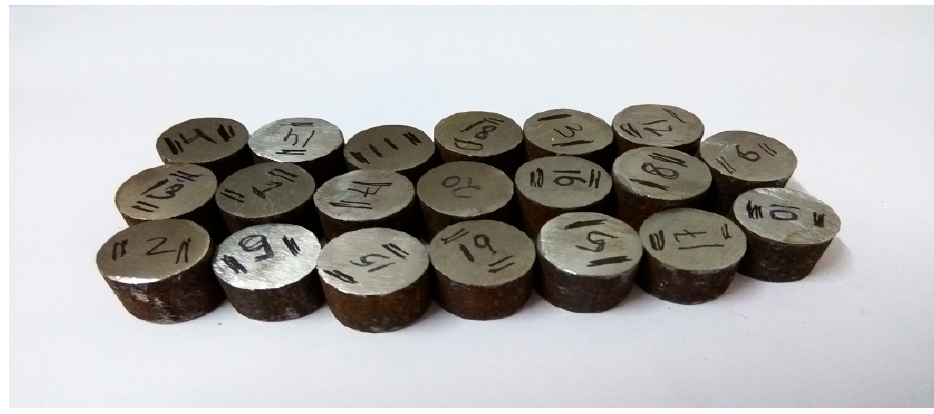
Figure 3. H13 work pieces. Table 1. H13 steel composition (wt.%).